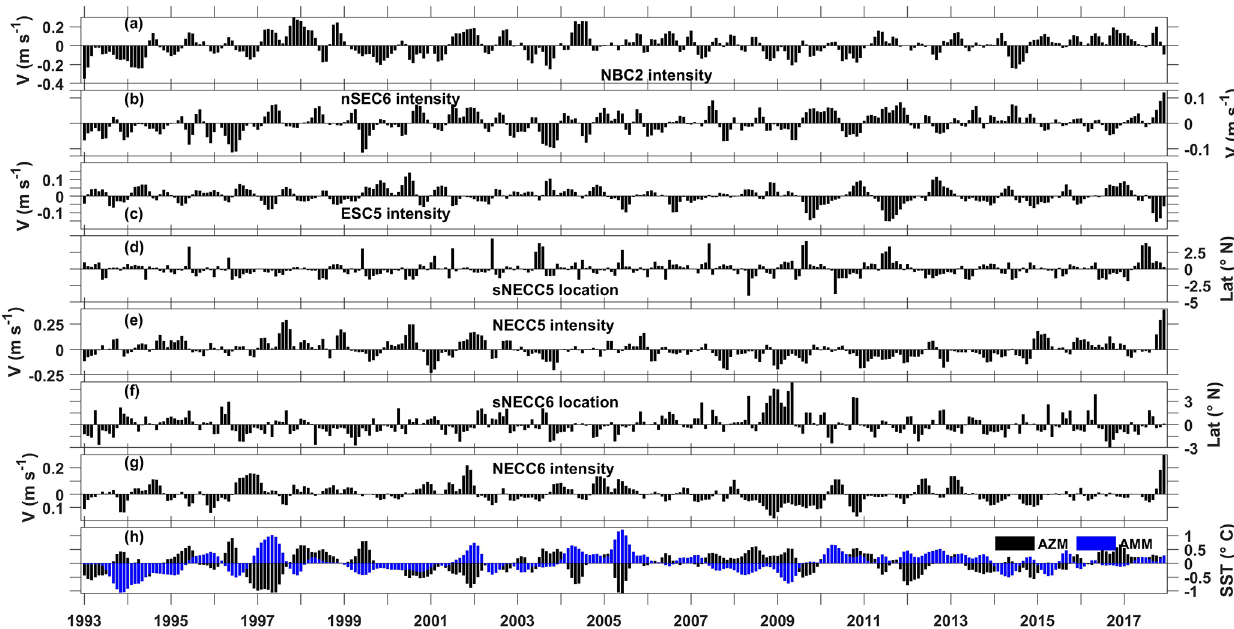
Figure 7. Time series of monthly anomalies relative to the monthly climatology for (a) the NBC2 intensity, (b) the nSEC6 intensity, (c) the equatorial surface eastward flow ESC5 intensity, (d) the sNECC5 core location, (e) the NECC5 intensity, (f) the sNECC6 core location, and (g) the NECC6 intensity. (h) Normalized indexes of the AMM (blue) and AZM (black).